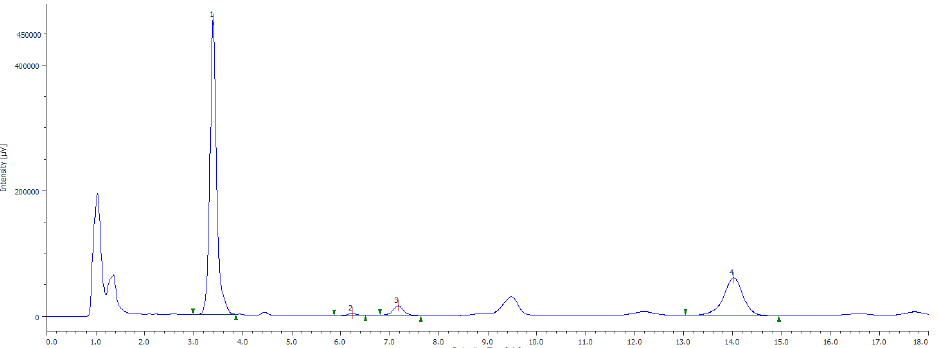
Figure 1. Example of a chromatogram obtained with fluorescence detection (FP-4025 fluorescence detector, Jasco, Tokyo, Japan) for the vitamin E profile of leaf samples of Cydonia oblonga Mill. assessed by HPLC-DAD-FLD (1 —α -tocopherol, 2 —β -tocopherol, 3 —γ -tocopherol, 4 — tocol/internal standard).